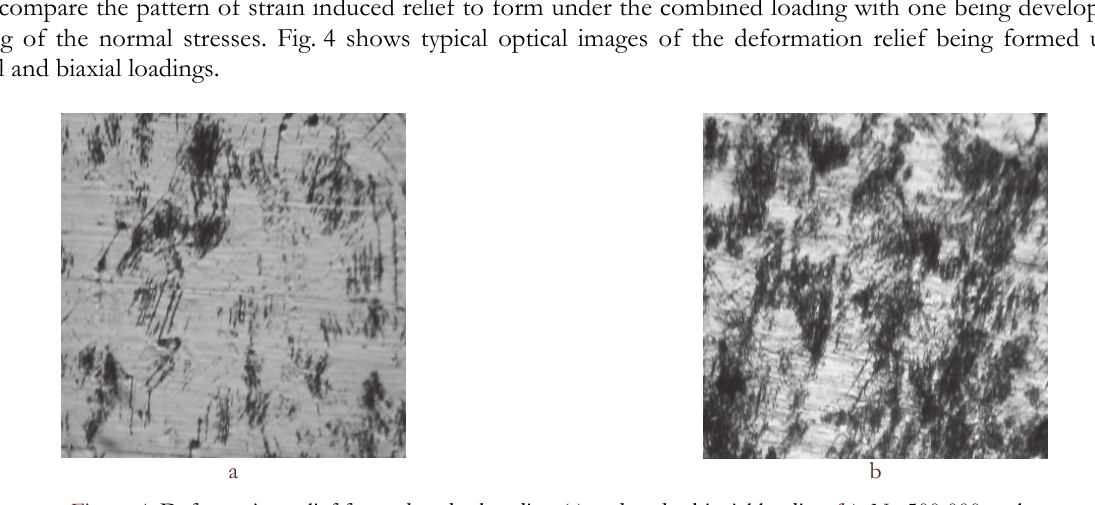
Figure 4: Deformation relief formed under bending (a) and under biaxial loading (b); N=500 000 cycles.